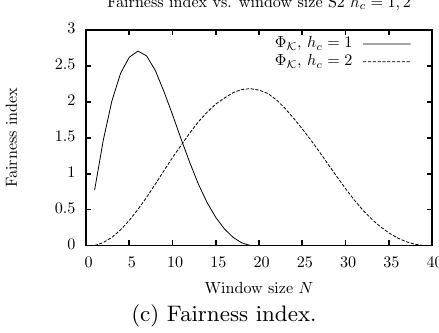
Figure 1: Performance in Scenario 1 with h c = 1 , 2